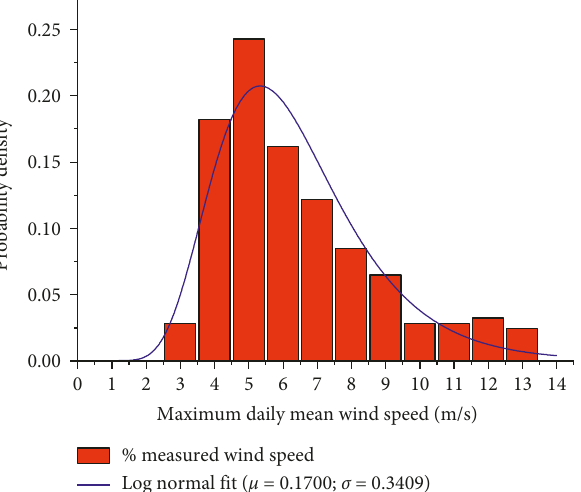
Figure 7: Probability distribution of the maximum daily mean wind